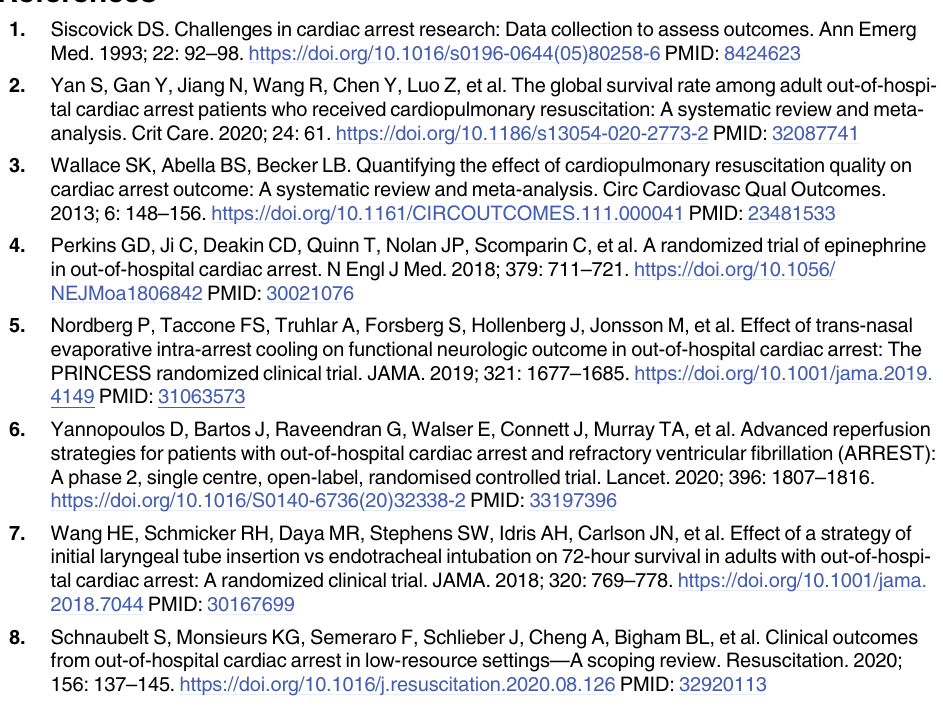
S2 Table. Patient background